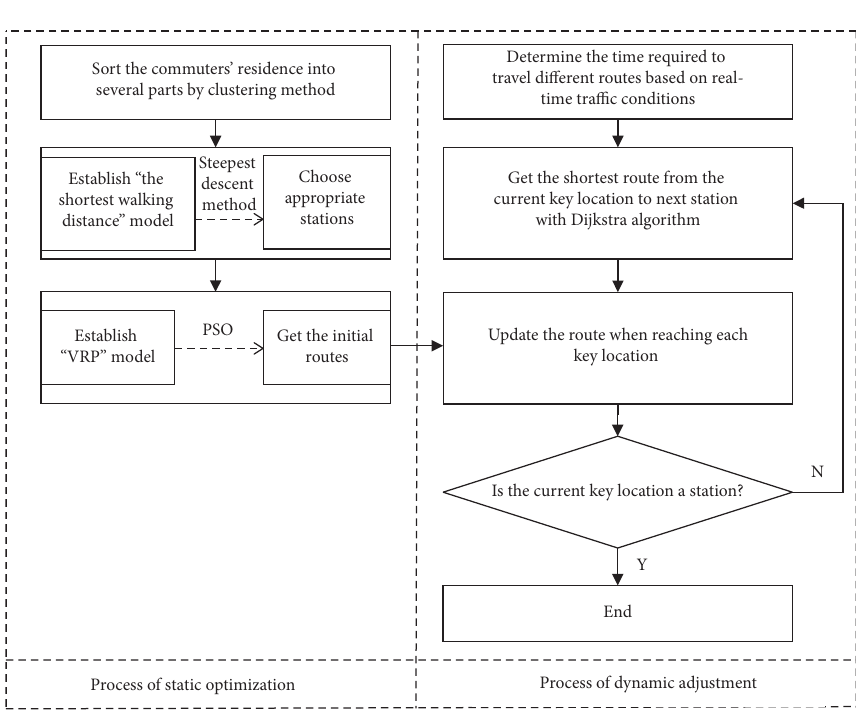
Figure 5: Algorithm